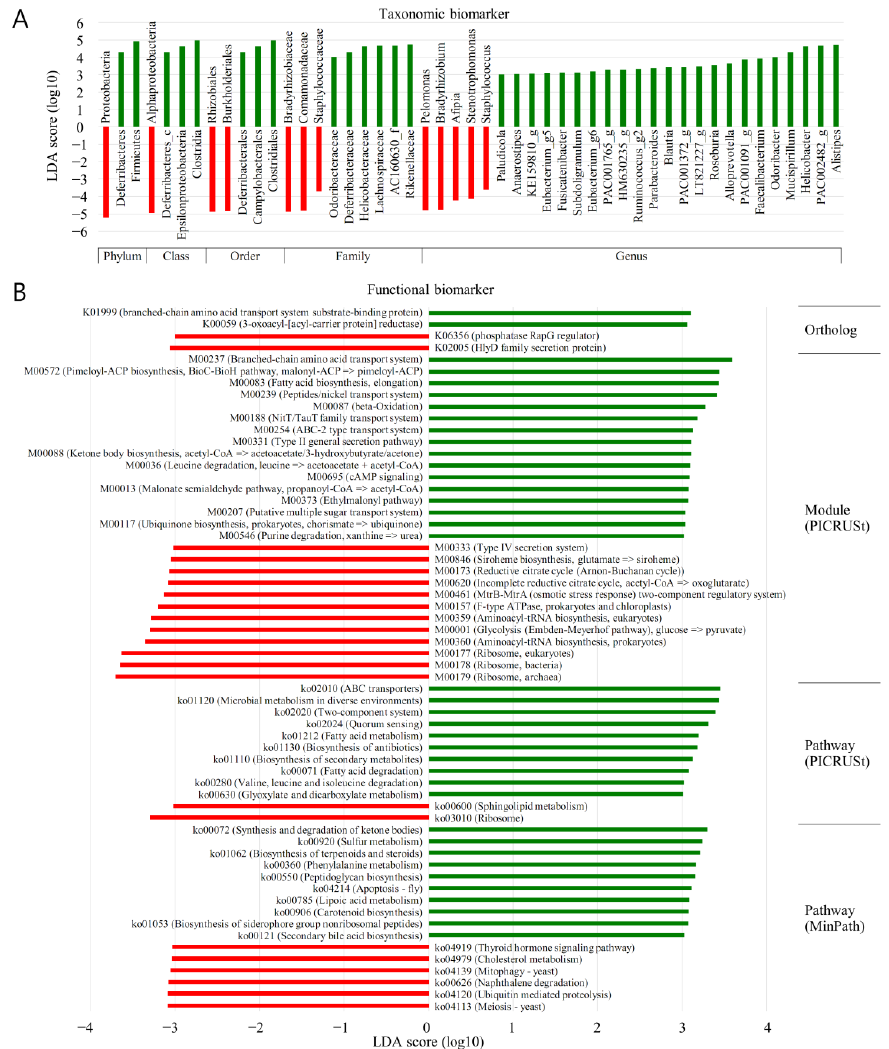
Figure 6. Discovery of taxonomic biomarkers and functional biomarkers in the benign prostatic tissue (N, normal) and tumour region in prostate cancer patients (T) using LEfSe (linear discriminant analysis effect size) analysis. ( A ) In addition to taxonomic biomarkers, ( B ) functional biomarkers were analysed in ortholog, module, and pathway. For module and pathway, PICRUSt (phylogenetic investigation of communities by reconstruction of unobserved states) and MinPath (minimal set of pathways) methods were applied, but there was no significant finding when MinPath was applied to module. The KEGG (Kyoto Encyclopedia of Genes and Genomes) Database was used for functional biomarker analysis. The red area indicates more abundance in the T group, and the green area indicates vice versa.